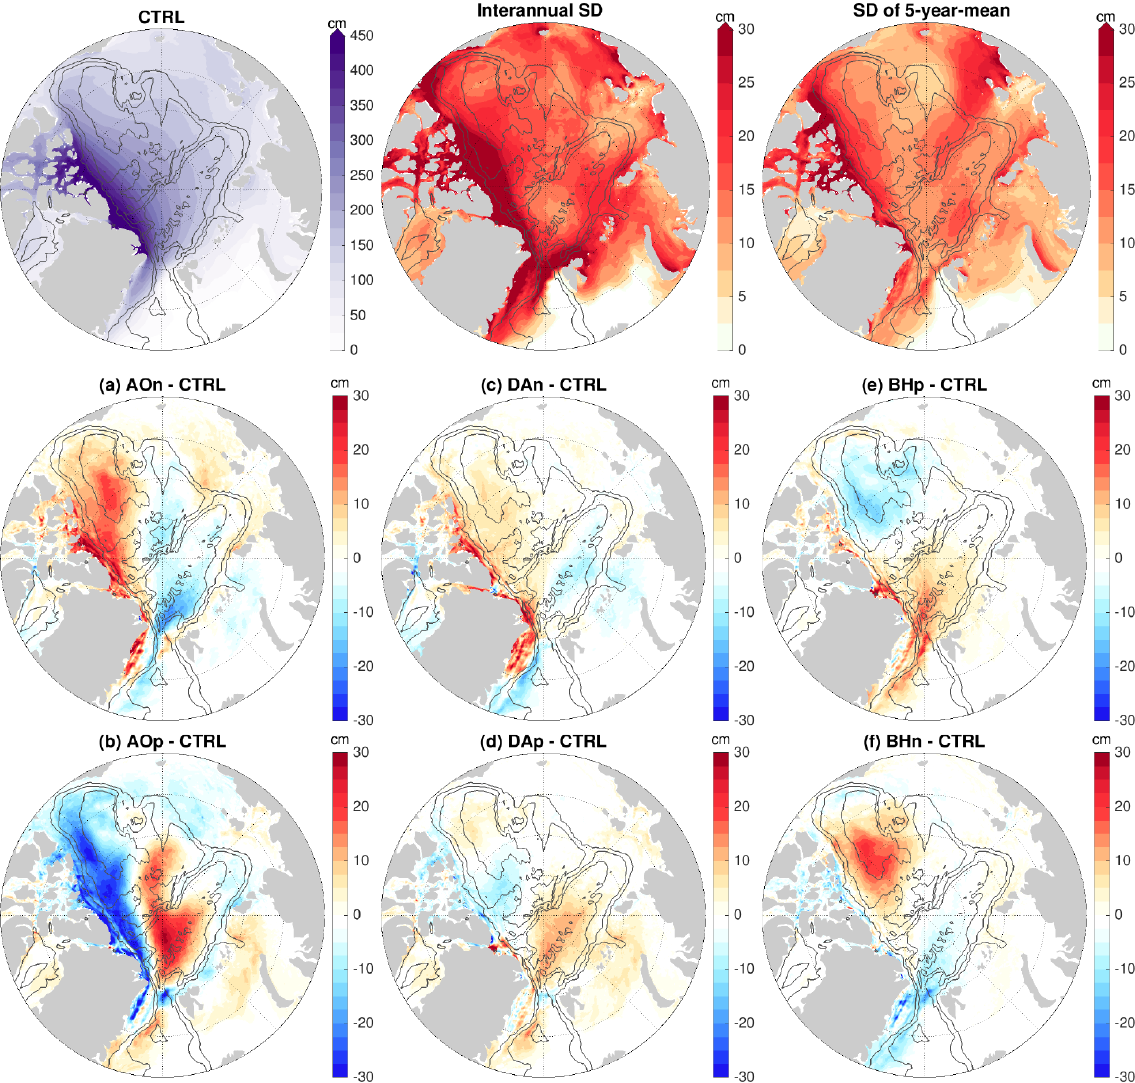
Figure 7. (a–f) Anomaly of sea ice thickness averaged over the 4 model years of the sensitivity simulations in which wind perturbations were switched off: experiments with an initial ocean spun up with the (a) negative phase of Arctic Oscillation (AO) forcing, (b) positive phase of AO forcing, (c) negative phase of Dipole Anomaly (DA) forcing, (d) positive phase of DA forcing, (e) positive phase of Beaufort High (BH) forcing and (f) negative phase of BH forcing. The anomalies are referenced to the control run result. The mean sea ice thickness in this period (left), the standard deviation (SD) of sea ice thickness on the interannual timescale in the 2010s (middle) and the SD of the pentadal mean in the period 1980–2019 (right) from the control run are shown at the top of the figure for reference. The black contour lines indicate the 500, 2000 and 3500m